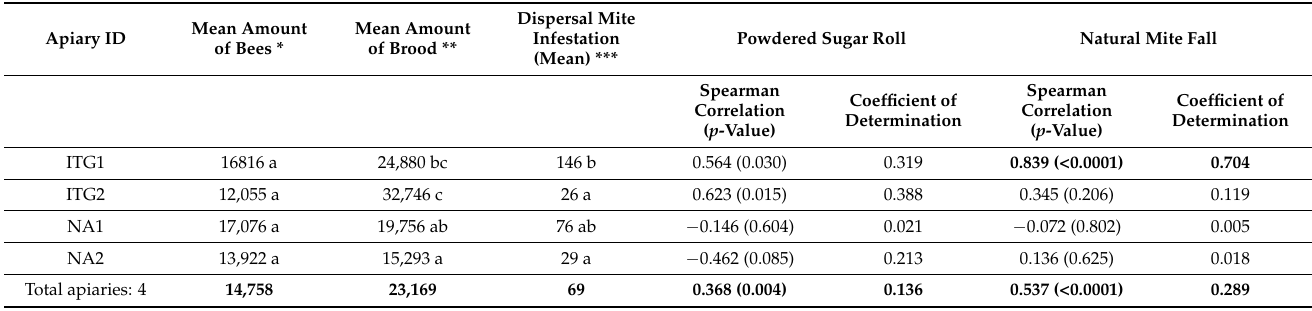
Table 2. Strength of colonies and dispersal mite infestation in the test apiaries. Correlation between the number dispersal mites in colonies and infestation of samples tested using different methods. Protocol 1